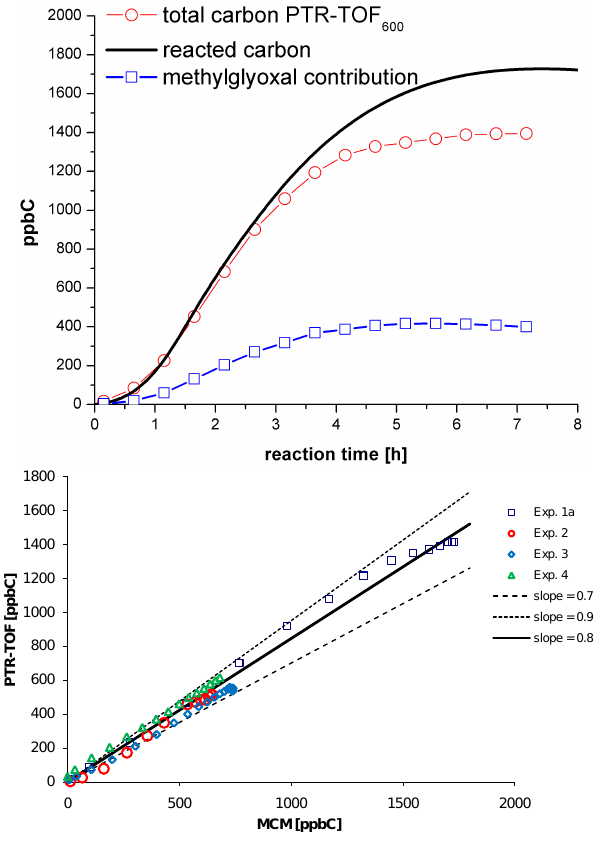
Fig. 4. (a) Time evolution of the total carbon concentration mea- sured in all TMB degradation products (major contribution from methylglyoxal shown individually) and the available amount of car- bon from TMB degradation. (b) Linear regression plot of mea- sured versus MCMv3.1 modeled total carbon formed during TMB